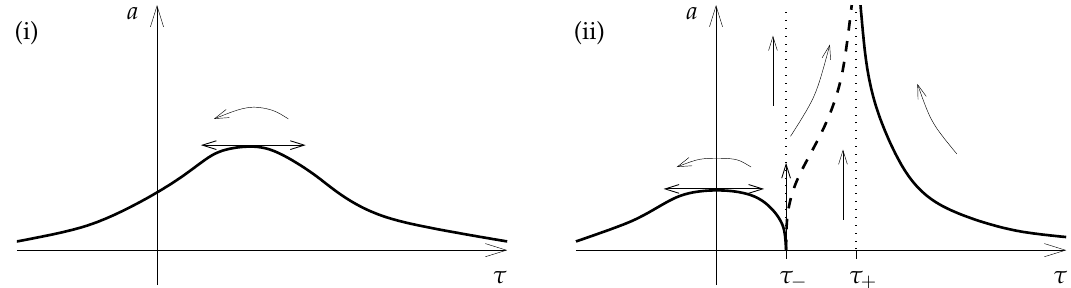
Figure 1. Qualitative behaviors of a ( τ ) , (i) in the supercritical and (ii) subcritical cases. The arrows indicate the directions of the evolutions for increasing cosmic time t , when c Φ > 0. Solid and dashed curves correspond to no-scale models with n F − n B < 0 and n F − n B > 0, respectively. Dotted lines describe the classical